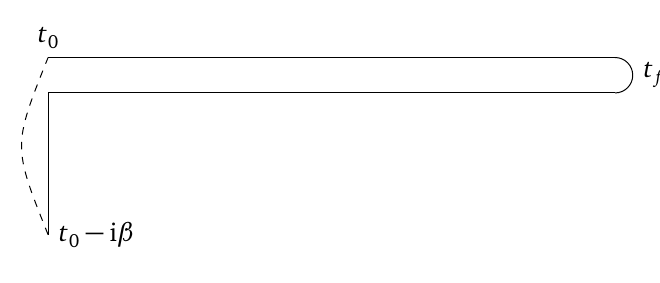
Figure 2: Finite temperature time